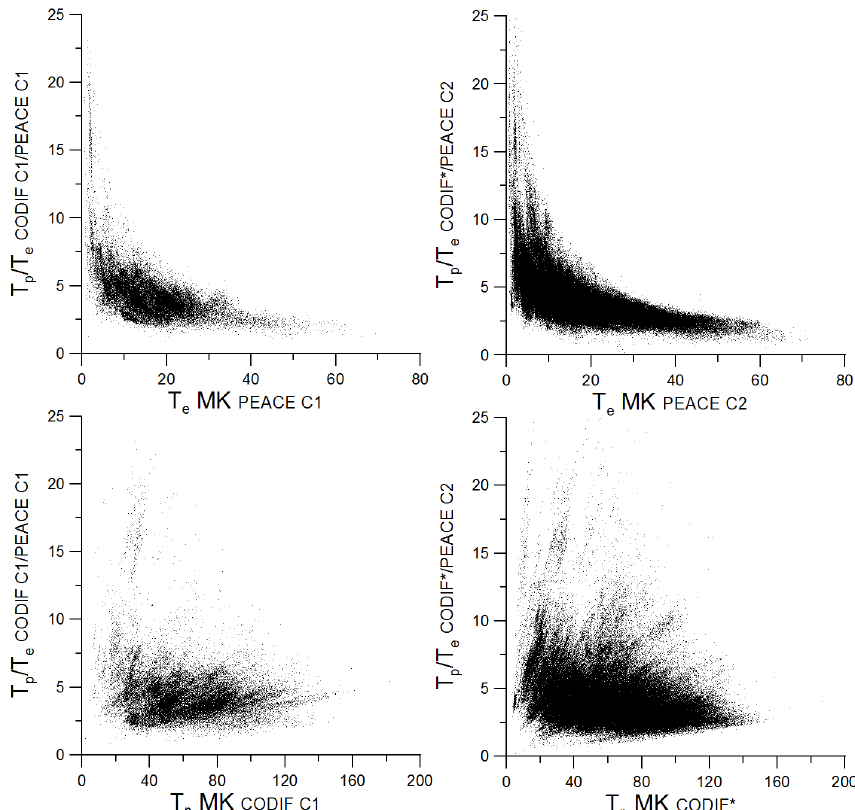
Fig. 3. Ratio T p /T e as functions of T e and T p for both statistics described in